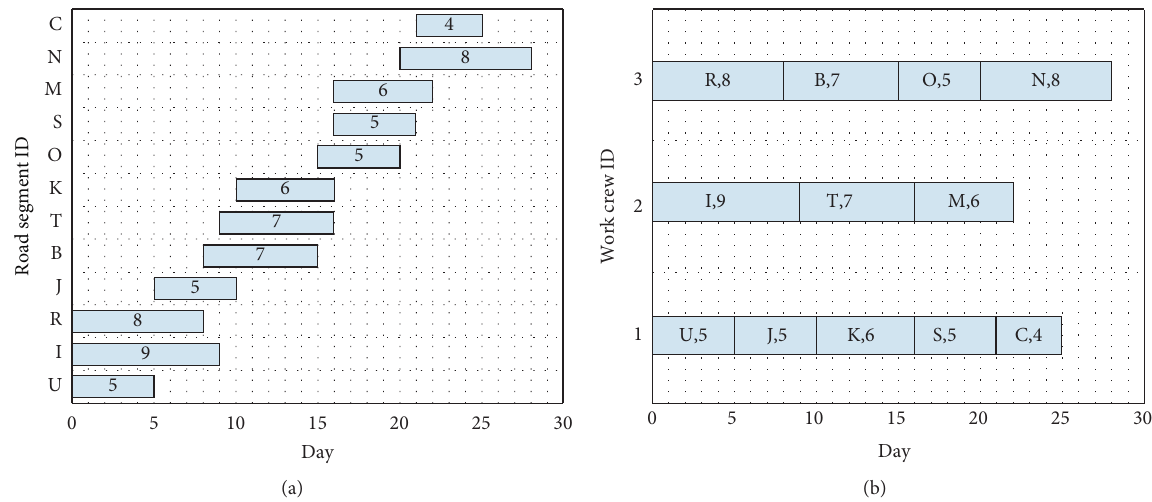
Figure 9: Flow-first restoration strategy: (a) time sequence of maintenance; (b) job sequence of work